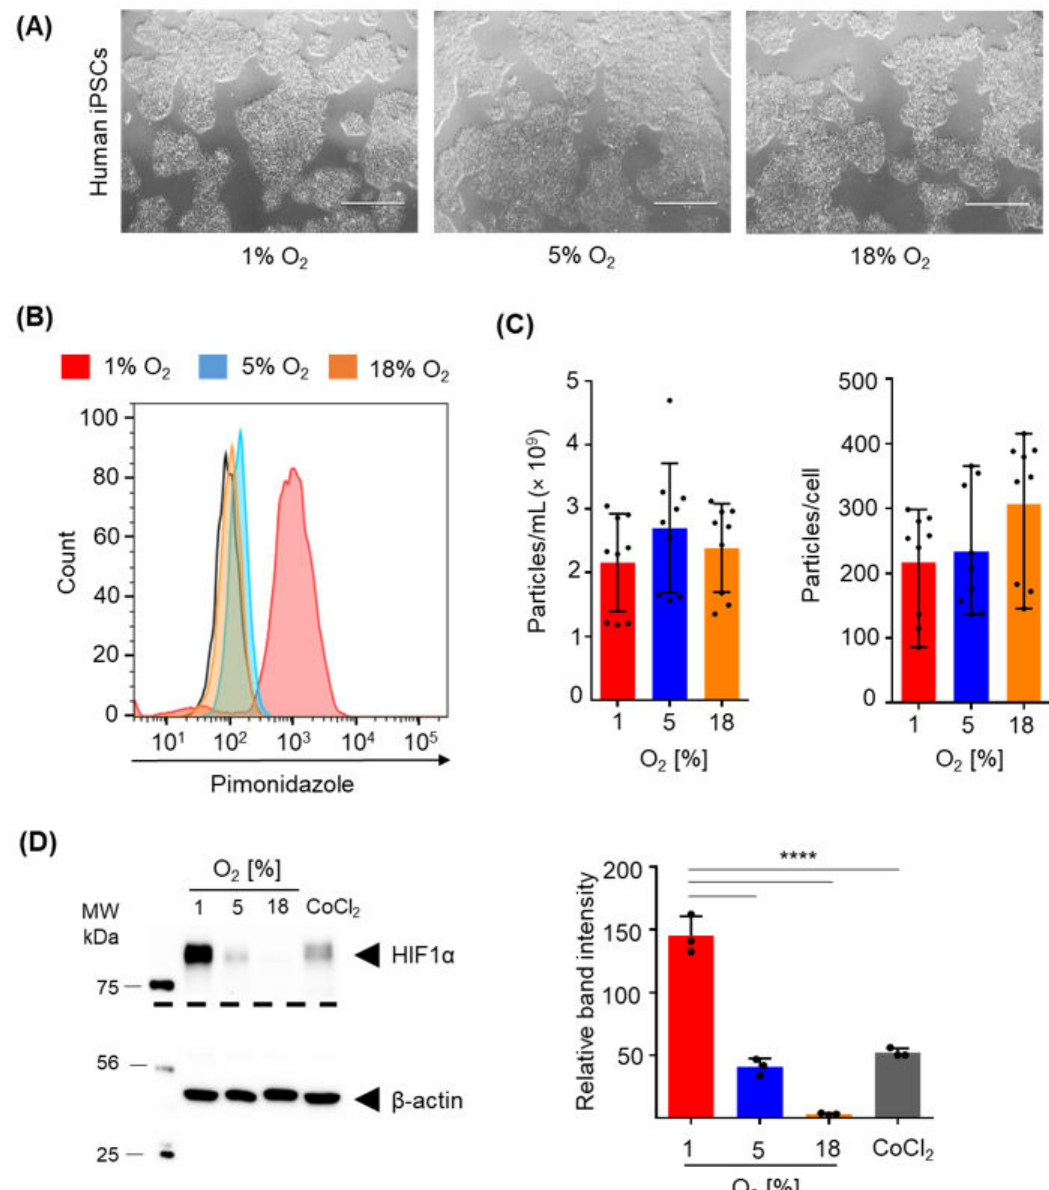
Figure 4. Conditioning of iPSCs at different oxygen levels during EV production. ( A ) Representative images of iPSC cultures at different oxygen levels as indicated. Scale bar 1000 µ m. ( B ) Formation of oxygen adducts measured by flow cytometry with the hypoxyprobe pimonidazole. Color code as indicated; black line shows unstained sample. ( C ) Particle concentration and particles secreted per cell per 24 h, by human iPSCs at indicated oxygen levels. Bars represent replicates from three independent experiments. ( D ) Representative immunoblotting for HIF-1 α levels in human iPSCs at different oxygen levels. CoCl 2 was used as a positive control for HIF-1 α stabilization. Protein quantification (relative band intensity) normalized to total protein loaded (right graph in ( D )). Bars represent mean ± SD results from three independent replicates (**** p <